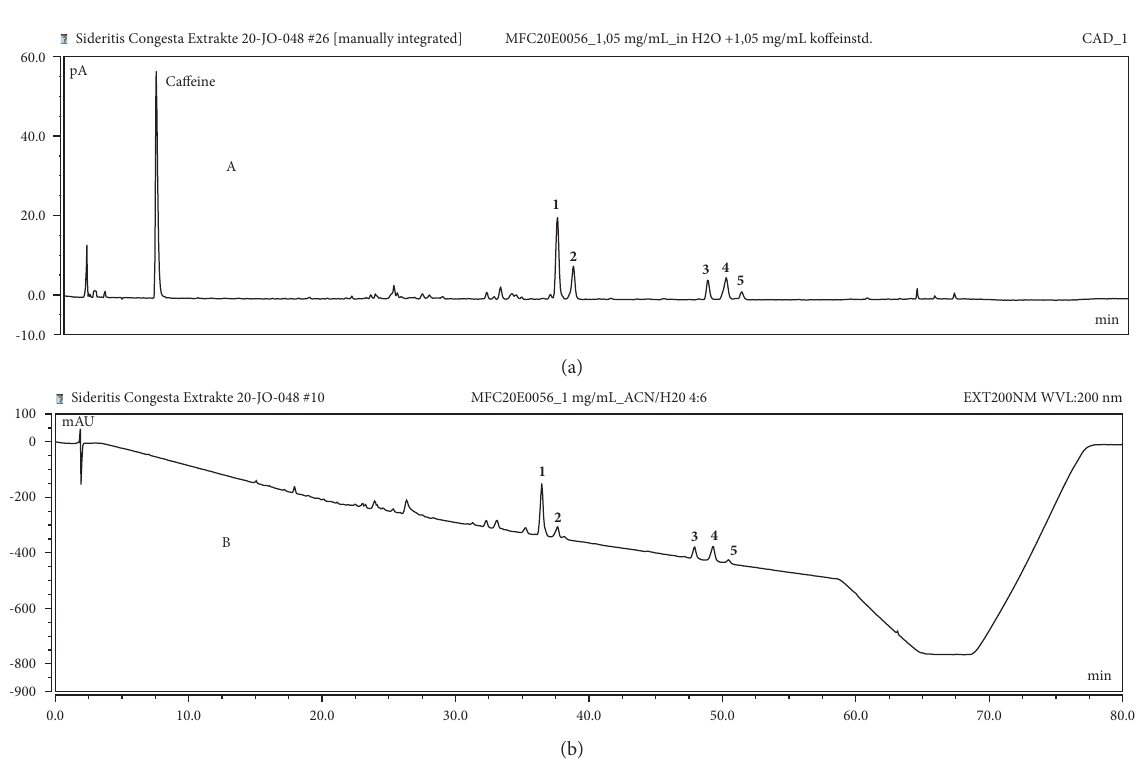
Figure 7: (a) An example HPLC-CAD chromatogram of fraction III used for the quantification of peaks 1–5 with caffeine as internal standard. (b) HPLC-PDA chromatogram of preparative separation of fraction III . The collection of the peaks 1–5 was performed with a fraction collector Foxy R1 (KNAUER) at 200nm. The obtained solutions were evaporated, and the dried residues were used for the structure identification via HRMS and NMR. Table 4: Quantification of five main peaks in fraction III . Peak